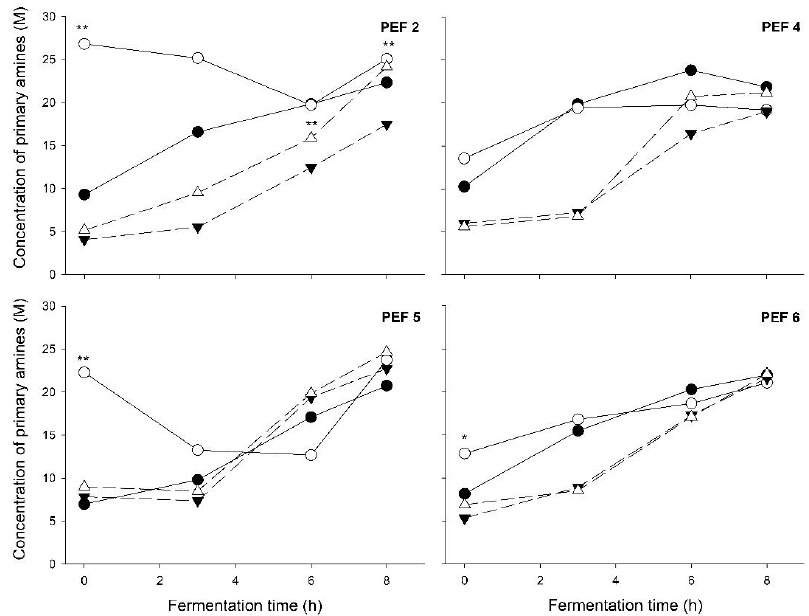
Figure 4. Proteolytic activity at different time points of yogurt fermentation made with differently PEF-treated starter cultures (PEF 2, PEF 4, PEF 5, PEF 6).  : control;  : PEF- PEF-treated starter cultures (PEF 2, PEF 4, PEF 5, PEF 6). • : control; treated;  : control + frozen;  : PEF-treated + frozen. Significant difference to the frozen; (cid:52) : PEF-treated + frozen. Significant difference to the respective control (control vs. PEF- respective control (control vs. PEF-treated; control + frozen vs. PEF-treated + frozen; treated; control + frozen vs. PEF-treated + frozen; paired t -test), *: p < 0.1; **: p < 0.05. Error bars were paired t -test), *: p < 0.1; **: p < 0.05. Error bars were removed for clarity. removed for